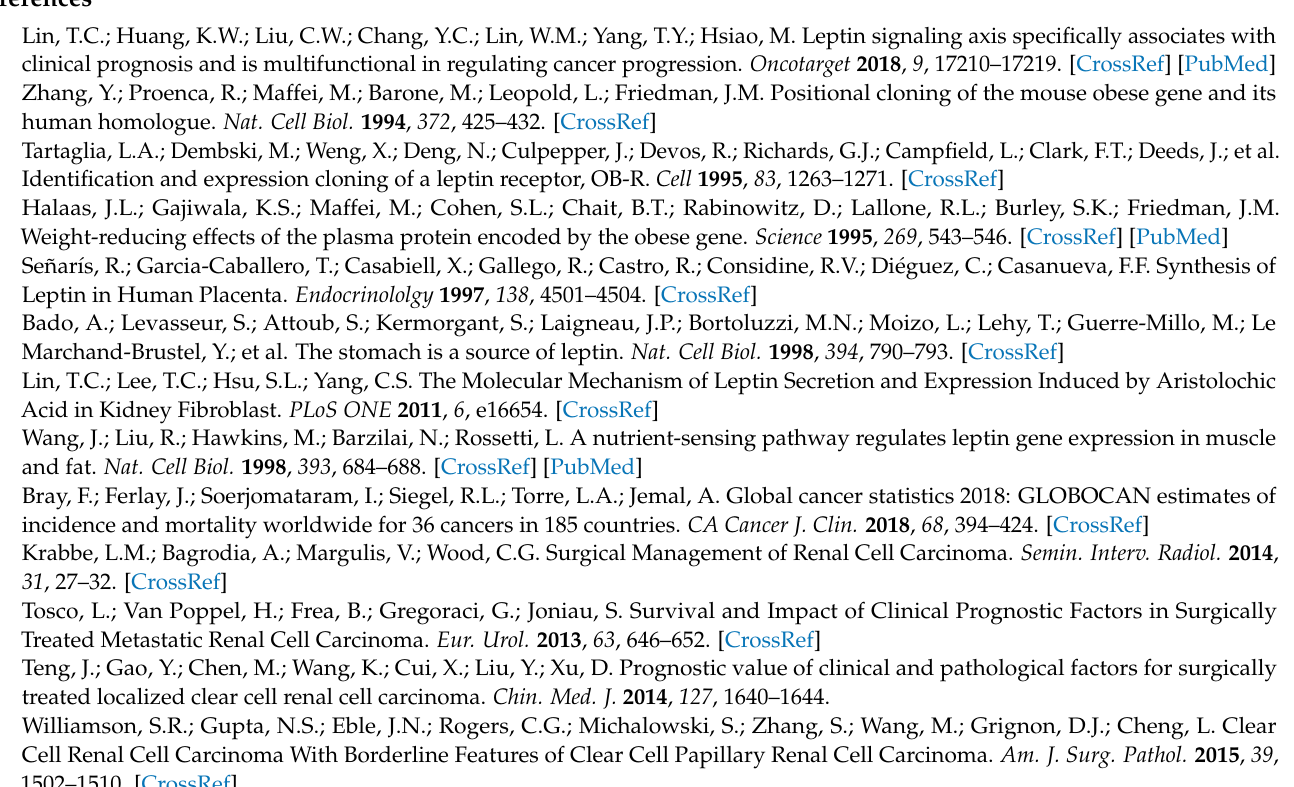
Figure S2: Pearson correlations of indicated molecular targets with LEP in the TCGA ccRCC cohort were evaluated, Figure S3: The expressions of indicated targets upon leptin treatment in ACHN cells, Table S1: Hierarchical Clustering, Table S2: IPA, Table S3: CCLE database, Table S4: Clinical information of TCGA